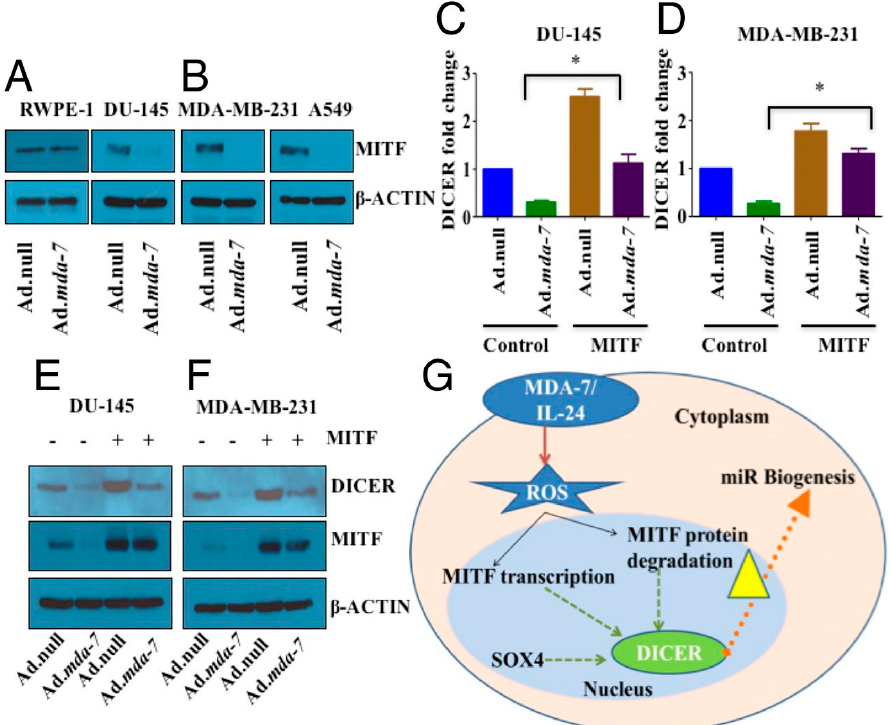
Figure 2. mda-7/IL-24 -mediated DICER regulation is controlled by the transcription factor MITF . mda-7/IL-24 downregulates MITF in different cancer cell lines ( A , B ), but not in normal RWPE-1 cells ( A ). DU-145 ( C ) and MDA-MB-231 cells ( D ) were transfected with vector or MITF, and then treated with Ad.null or Ad. mda-7 . RNA was isolated 72 h post infection, and real-time quantitative PCR was done to check the level of DICER. DU-145 ( E ) and MDA-MB-231 cells ( F ) were treated as described in ( C , D ), total protein was isolated, and Western blotting was done with DICER and MITF antibodies. Actin was used as a loading control. ( G ) Schematic representation of regulation of the miRNA processing enzyme DICER by mda-7/IL-24 . MDA-7/IL-24 downregulates the transcription factor MITF in a ROS-dependent manner, which in turn downregulates DICER. RWPE-1 (immortalized human prostate epithelial cell line); DU-145 (human prostate cancer cell line); MDA-MB-231 (human breast cancer cell line); and A549 (human lung cancer cell line). Reprinted by permission from Pradhan et al., 2019 [39]. *: p < 0.05.